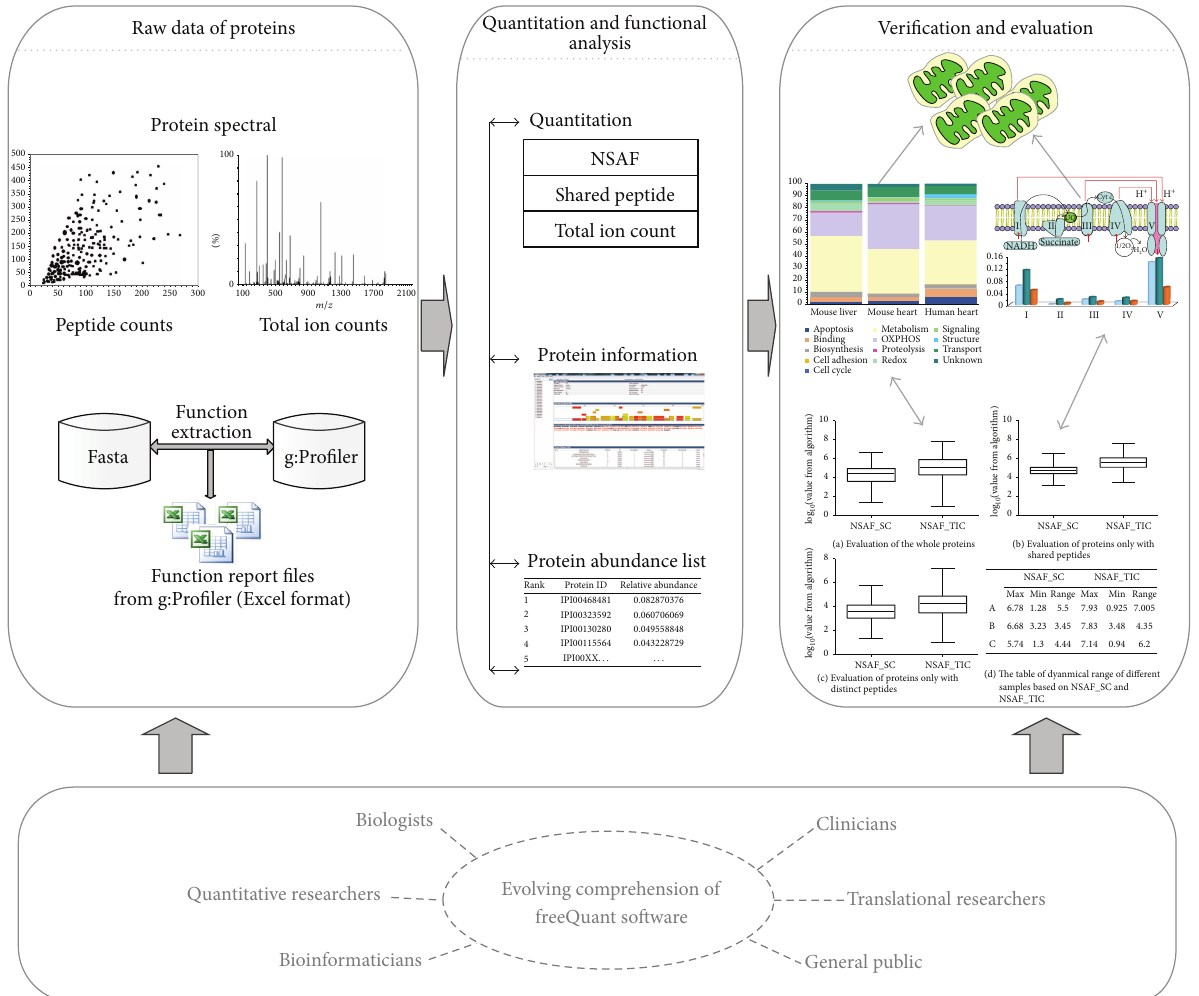
Figure 3: The data analysis pipeline with freeQuant. Three steps were involved. First, raw data were extracted to obtain spectral counts and total ion counts; functional profiling files were achieved through g:Profiler. Second, quantification coupled with biomedical knowledge was analyzed with freeQuant software toolkit using NSAF, MS/MS TIC, and shared peptides. Final, mitochondrial proteins were quantified